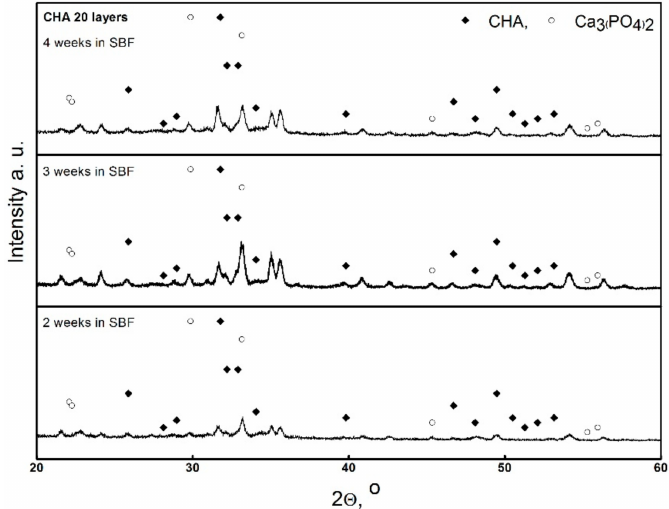
Figure 11. XRD patterns of CHA samples coated with 20 layers after immersion in SBF for 2, 3, and 4